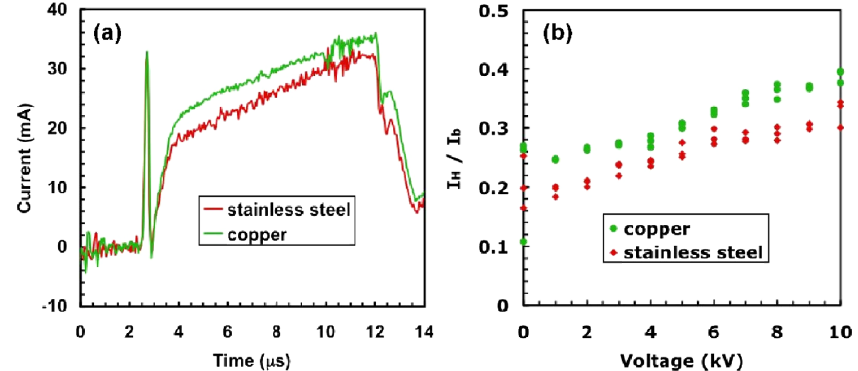
FIG. 17. (Color) (a) Ionized gas current collected on the parallel plates biased at (cid:10) 10 kV when intercepting the beam with a stainless steel plate (red) and a copper plate (green); (b) ratio of the ionized gas current ( I ) versus bias potential over a 200 ns gate at 3 : 2 (cid:1) s . the beam current ( I b